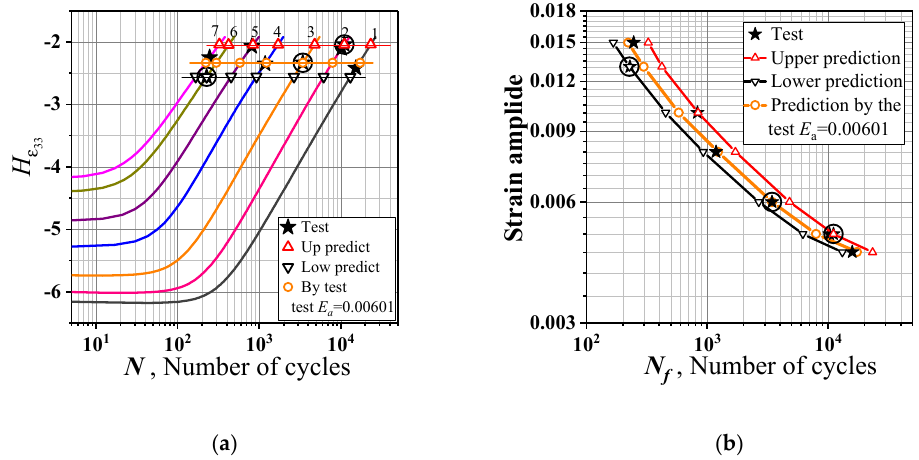
H Figure 12. Verification of FIP : ( a ) determining upper and lower of critical value and determin- Figure 12. Verification of FIP H ε : ( a ) determining upper and lower of critical value and determining ε 33 33 point sequences ( N predict , E a ) ; ( b ) predicted fatigue-life curves and their comparison with N E ; ( b ) predicted fatigue-life curves and their comparison with tests. ing point sequences predict ( , ) f f a